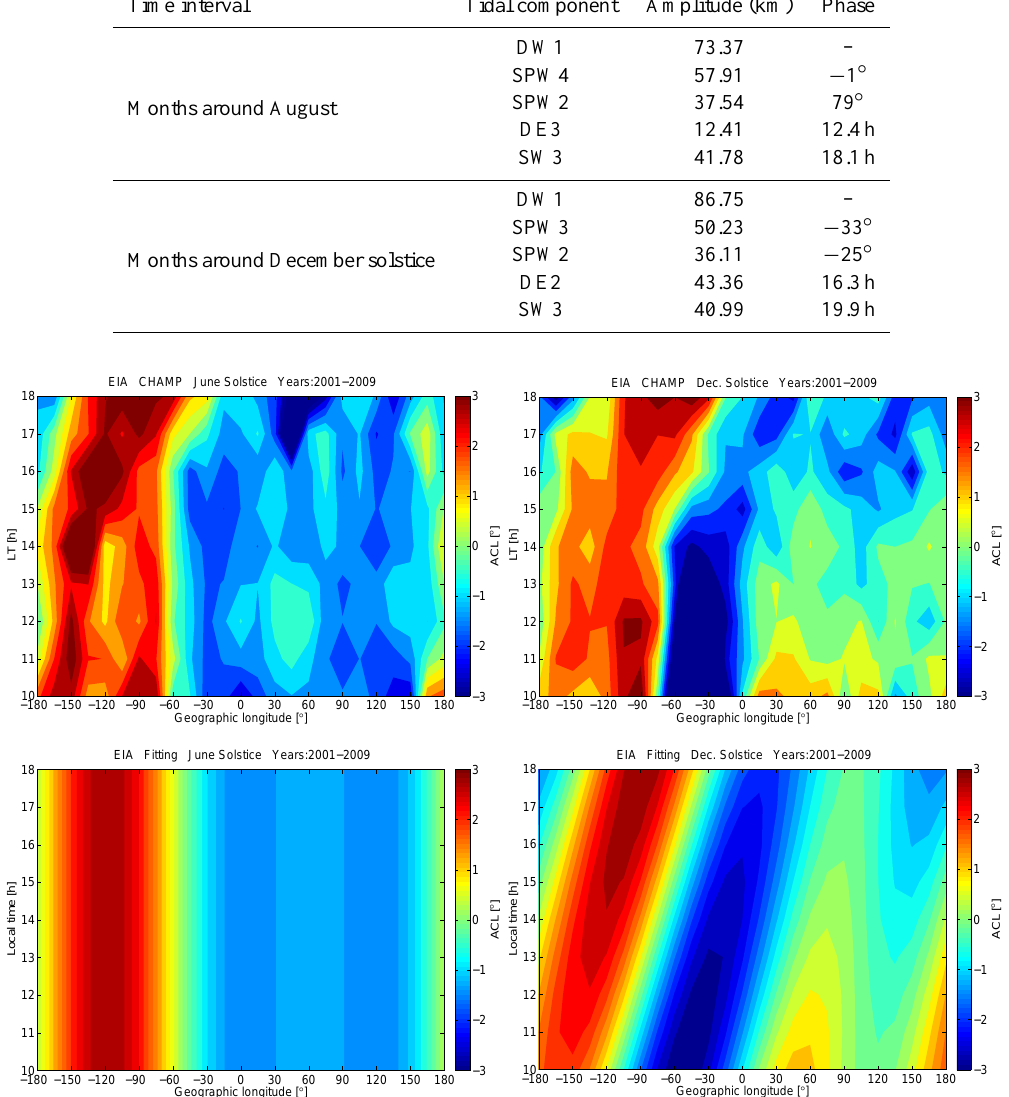
Fig. 8. The local time versus longitudinal distribution of ACL, observations (top) and synthetic signal (bottom) during the months around June (left) and December